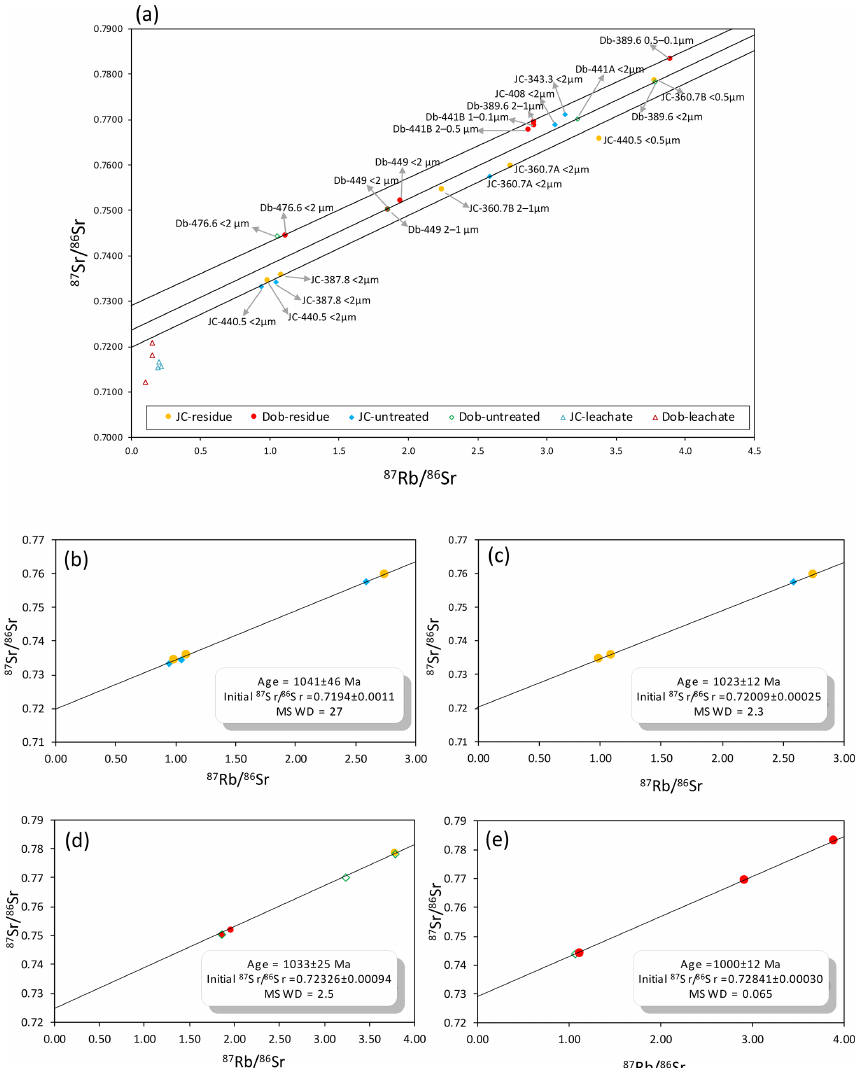
Figure 8. (a) Rb–Sr data of the different size fractions and the untreated leachate and residue separates of each size fractions from samples. Parallel linear relationships correspond to similar isochron age but with different initial 87 Sr / 86 Sr values. (b) Rb–Sr plot for untreated fractions with residues of of < 2µm from most Julia Creek 1 samples. (c) Well-defined isochron for Julia Creek 1 samples after omitting two untreated aliquots, (d) Rb–Sr isochron diagrams for an assemblage of Dobbyn 2 samples (including JC-360.7B < 0.5µm), and (e) another group of Dobbyn 2 samples with a younger